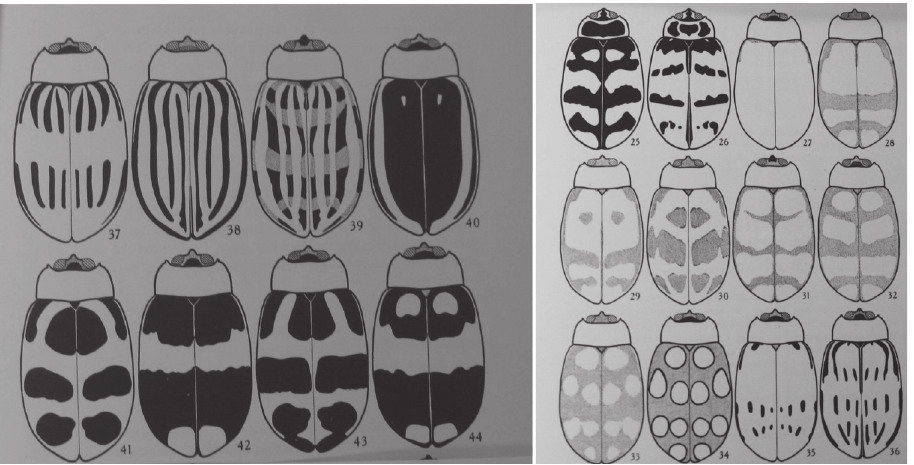
Figure 15. Alagoasa decemguttata intraspecific variation (ex Bechyné, 1955).